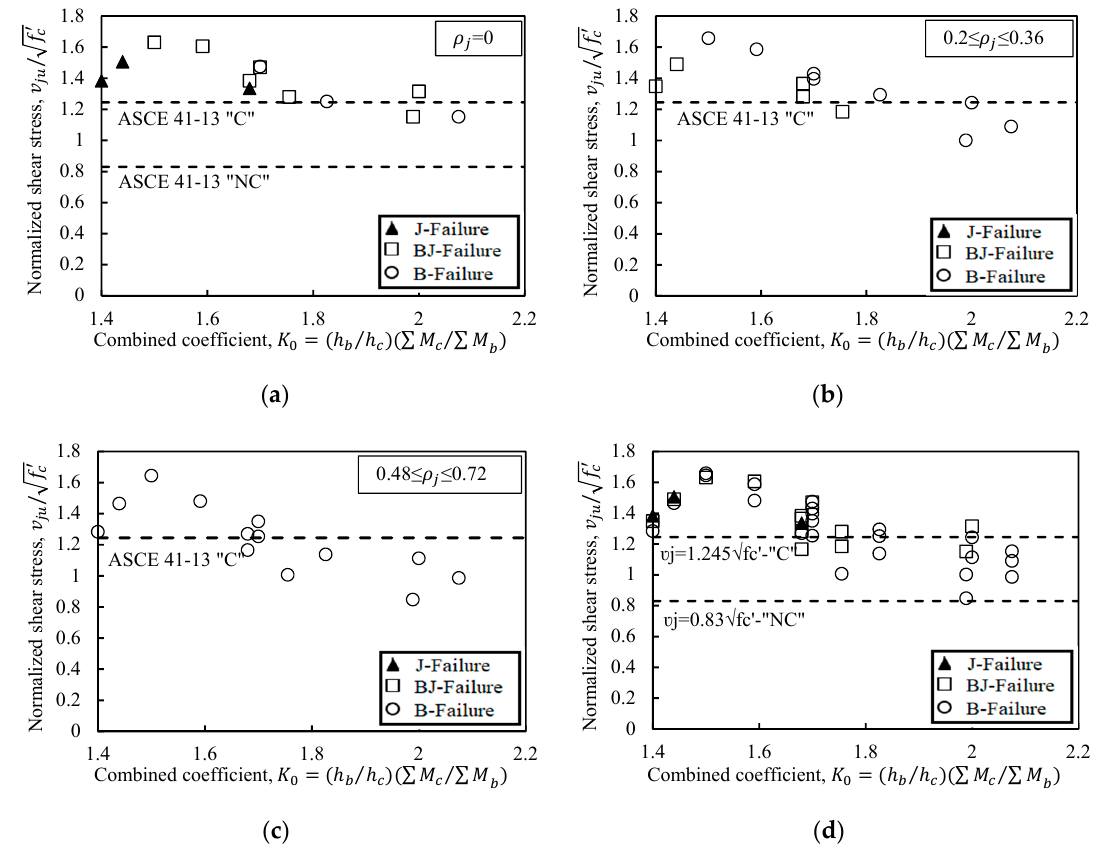
Figure 16. Maximum shear stress at the interior joints for different combinations of design variables: ( a ) no joint reinforcement ratio; ( b ) low joint reinforcement ratio; ( c ) moderate joint reinforcement ratio; ( d ) total design variables.